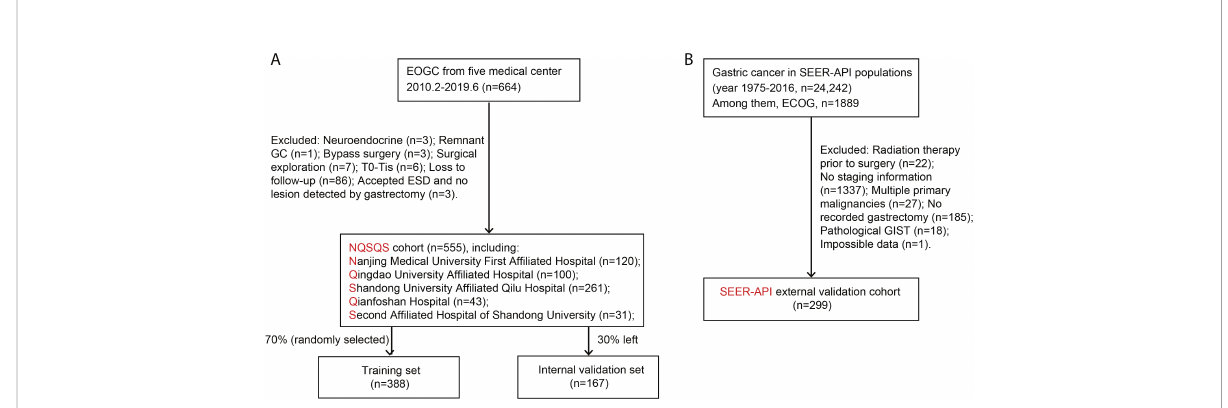
FIGURE 1 Patients ’ enrollment and exclusion fl ow chart. (A) The NQSQS cohort included 555 EOGC patients from fi ve medical centers in China, which was further divided into training set (n=388) and internal validation set (n=167). (B) The SEER-API cohort included 299 Asian or Paci fi c Islander (API) EOGC patients selected from SEER